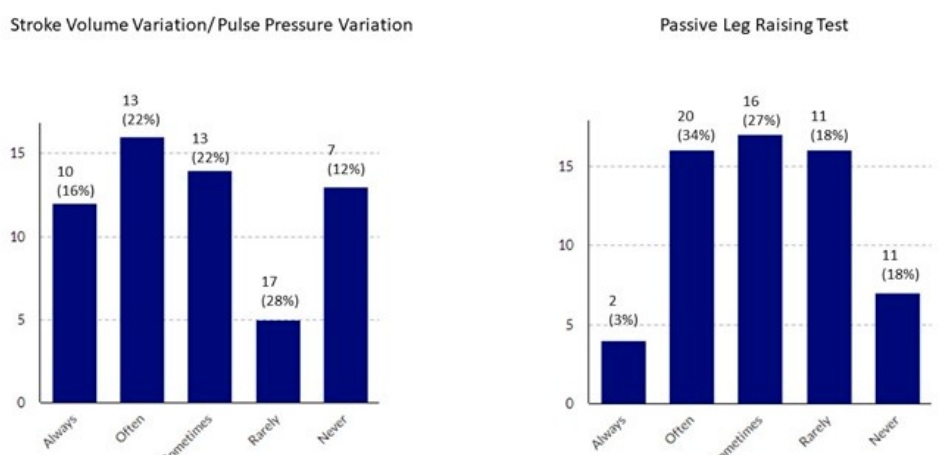
Figure 3. Methods of fluid responsiveness assessment utilized in the ICU environment.